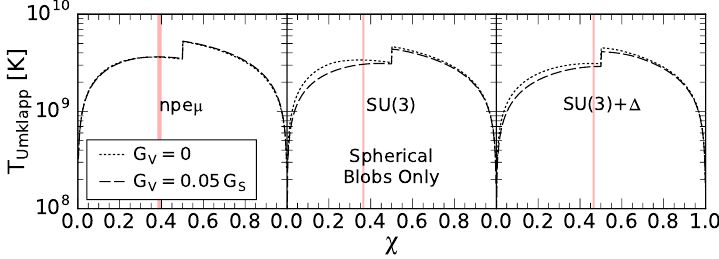
Figure 5. Temperature below which Umklapp processes are frozen out ( T Umklapp ), and contributions to the neutrino emissivity due to electron–phonon interactions become negligible for the DD2 parametrization [7]. See Figure 2 for additional details. Similar figures for the SWL, GM1L, and ME2 parametrizations can be found in